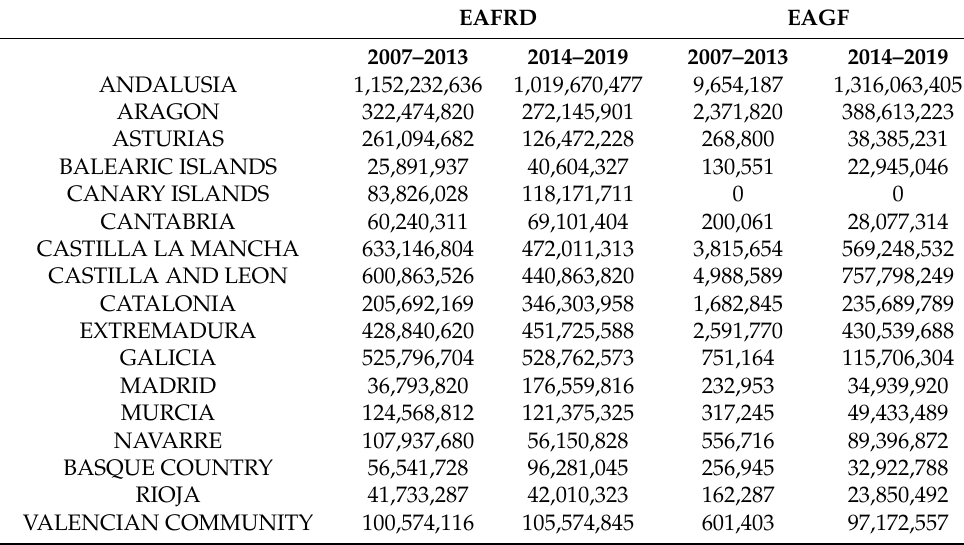
Table 1 presents the distribution of the EAGF and EAFRD funds in the 17 Spanish regions. Table 1. Distribution of EAFRD and EAGF funds in Spanish regions (Source: Own elaboration from data published by the Ministry of Agriculture, Fisheries, and